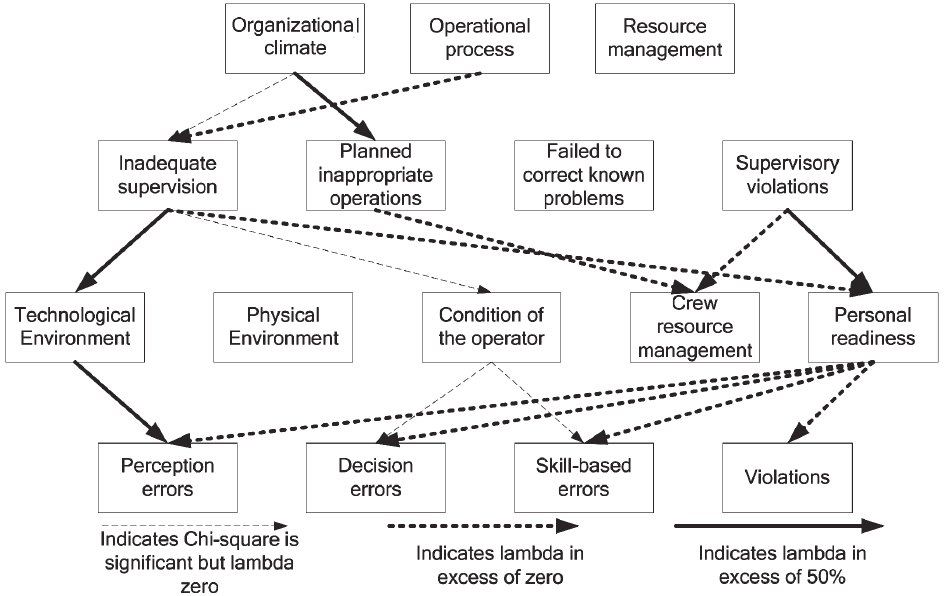
Figure 4. The simple associations graphs of hit by objects accident